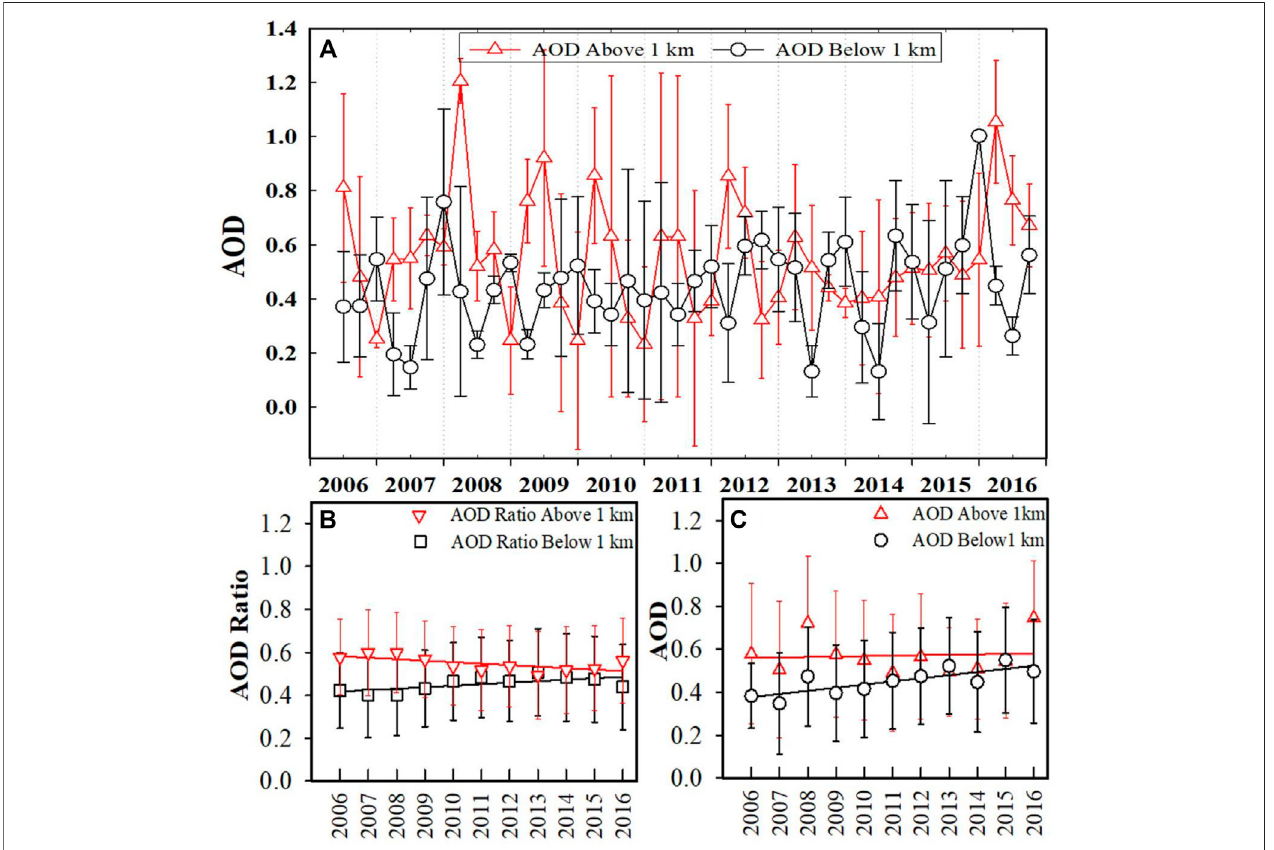
FIGURE 8 | (A) Seasonal variation of the aerosol optical depth (AOD) ratio as mentioned in Eq. 4 during the period 2006 – 2016 for spring (March – April – May), summer – monsoon (June – July – August), autumn (September – October – November), and winter (December – January – February). (B) Trend in the annual mean AOD ratio above and below 1 km. (C) Trend in AOD above and below 1 km is also shown. The error bars shown here represent standard deviation. The Cloud-Aerosol Lidar and Infrared Path fi nder Satellite Observations (CALIPSO) – derived aerosol extinction pro fi le has been used for AOD estimations at a 2-degree grid region around the observational site